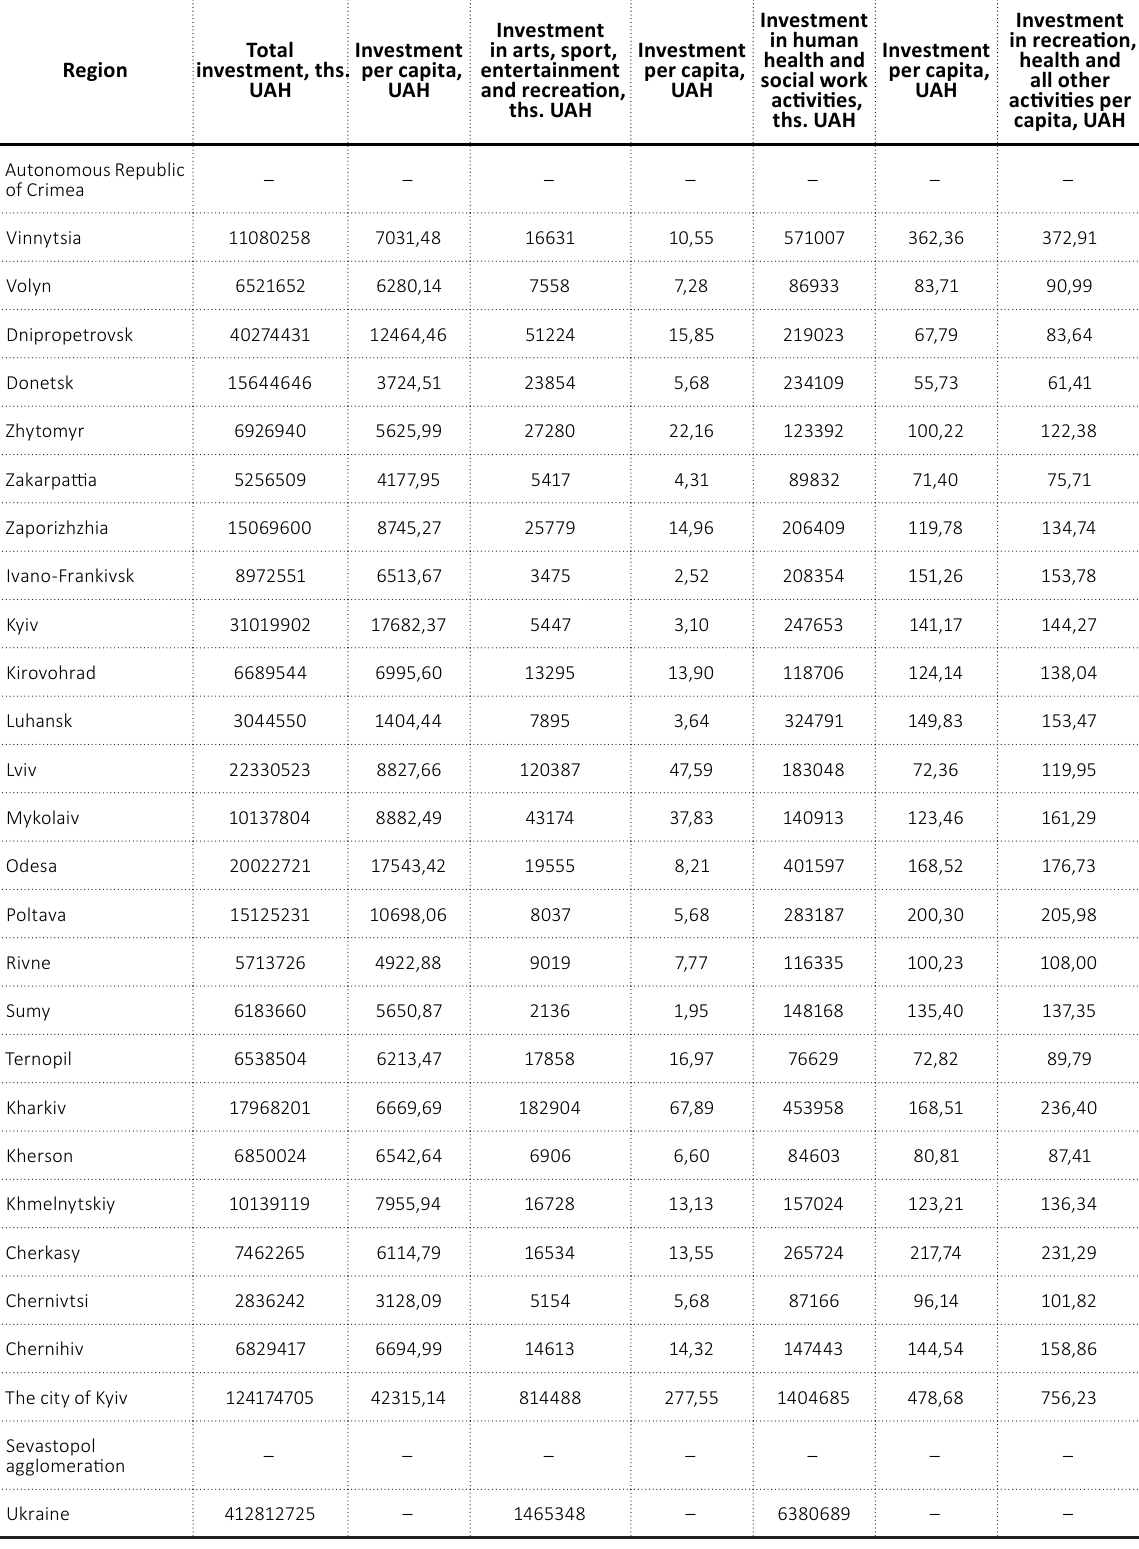
Table A2. Investment in recreation and wellness by regions of Ukraine Source: Calculated by the authors based on the State Statistics Service of Ukraine data. Investment in arts, sport, Total Investment Region per capita, entertainment investment, ths. UAH UAH and recreation, ths.